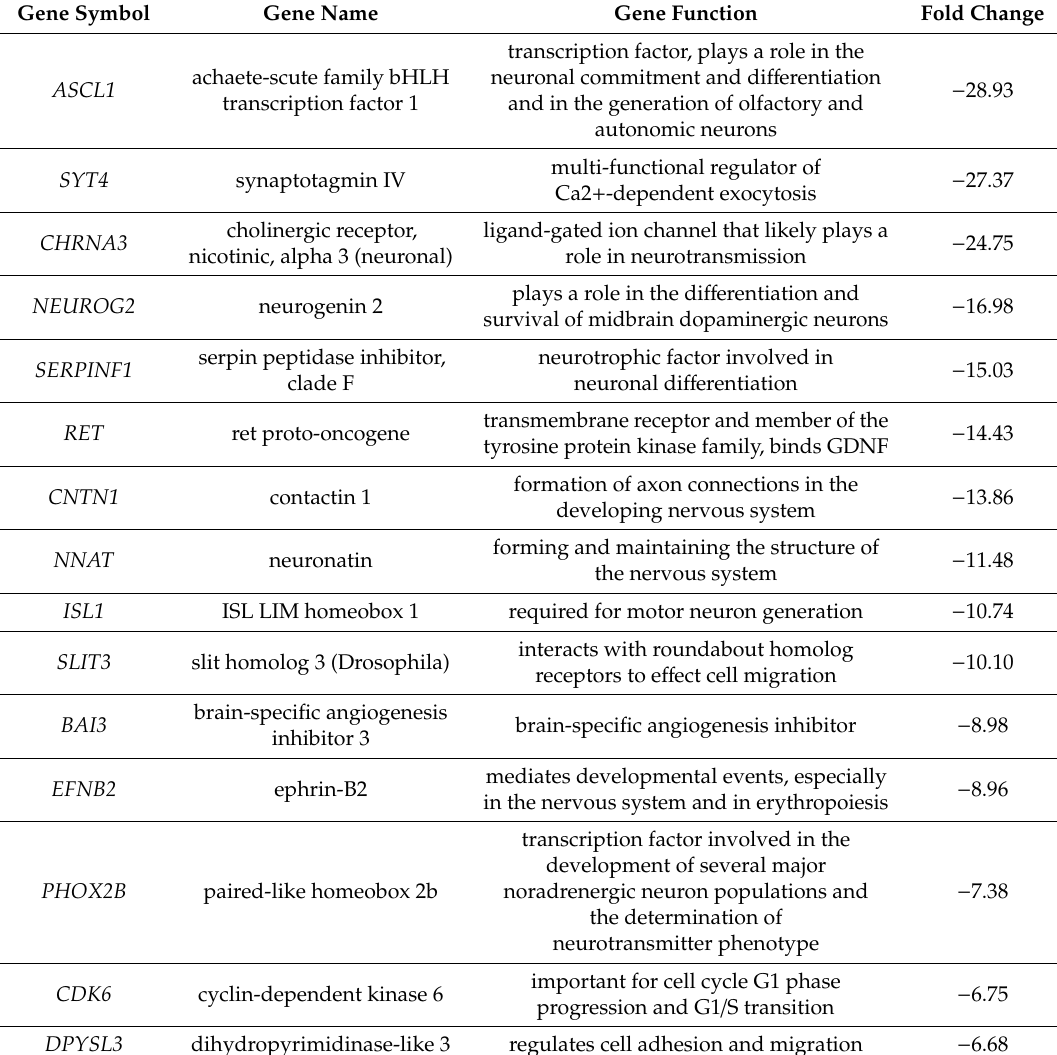
Table 1. The list of 15 most downregulated genes involved in neurogenesis in bortezomib-treated SH-SY5Y cells compared to controls. Gene function according to NCBI Gene